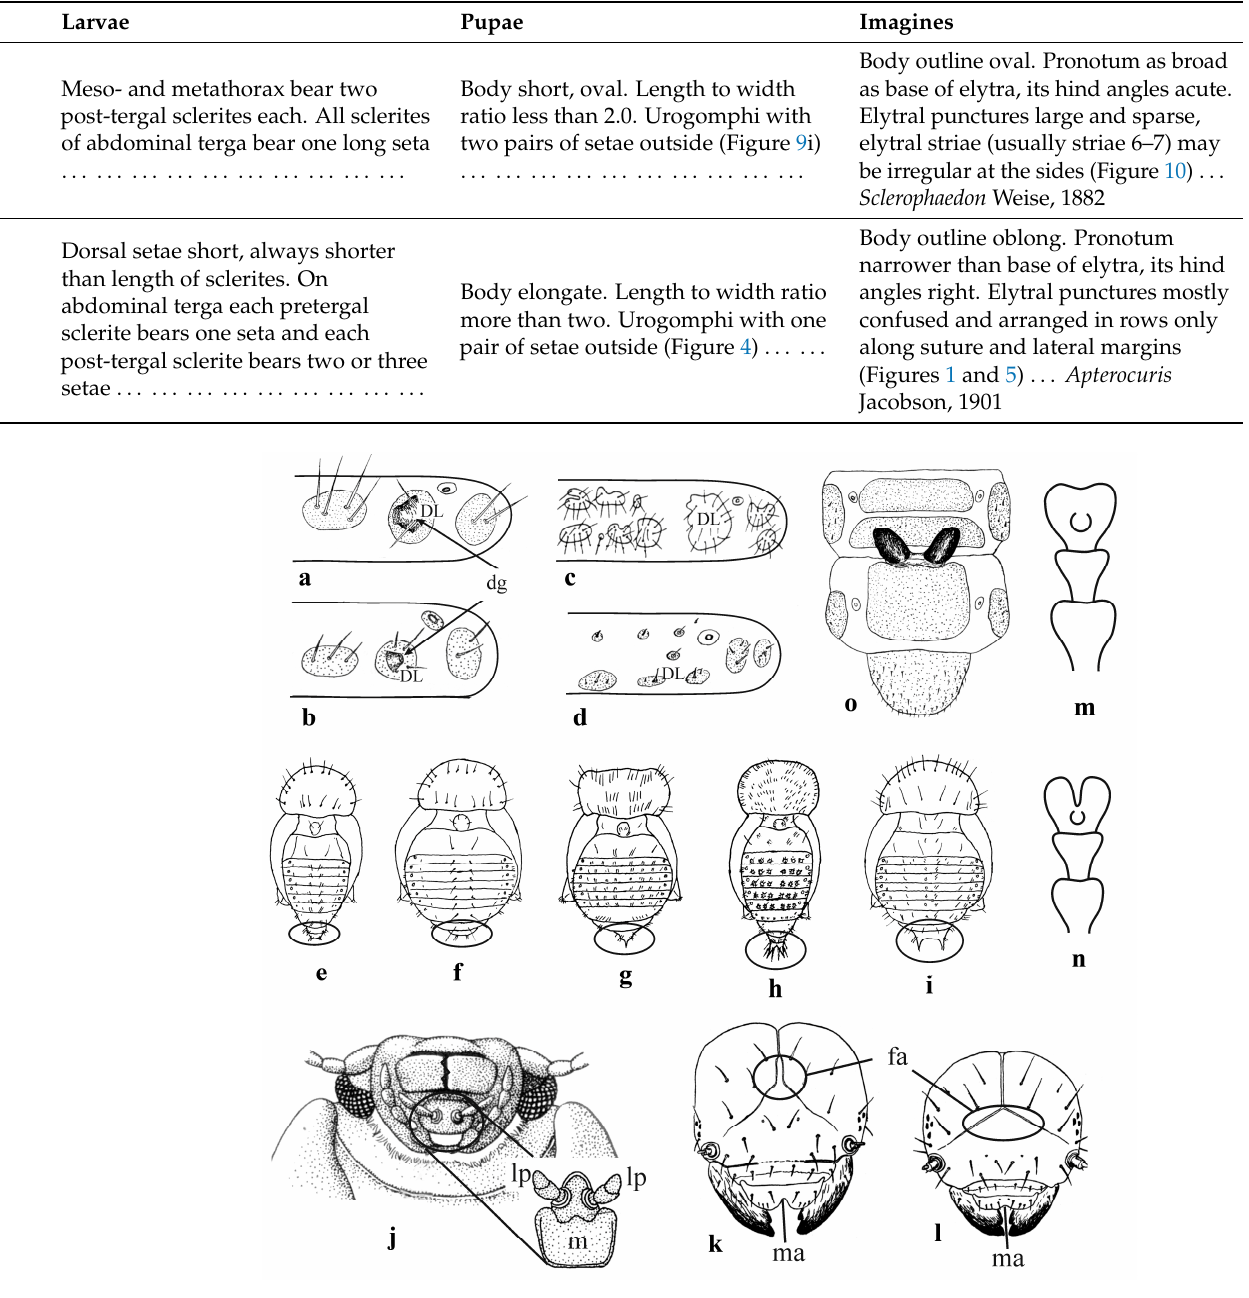
Figure 9. Morphological details of larvae, pupae and adult leaf beetles: ( a )—abdominal tergum 2 of larva of Sternoplatys clementzi Jacobson, 1901 (DL—dorsolateral sclerite; dg–dorsal defensive